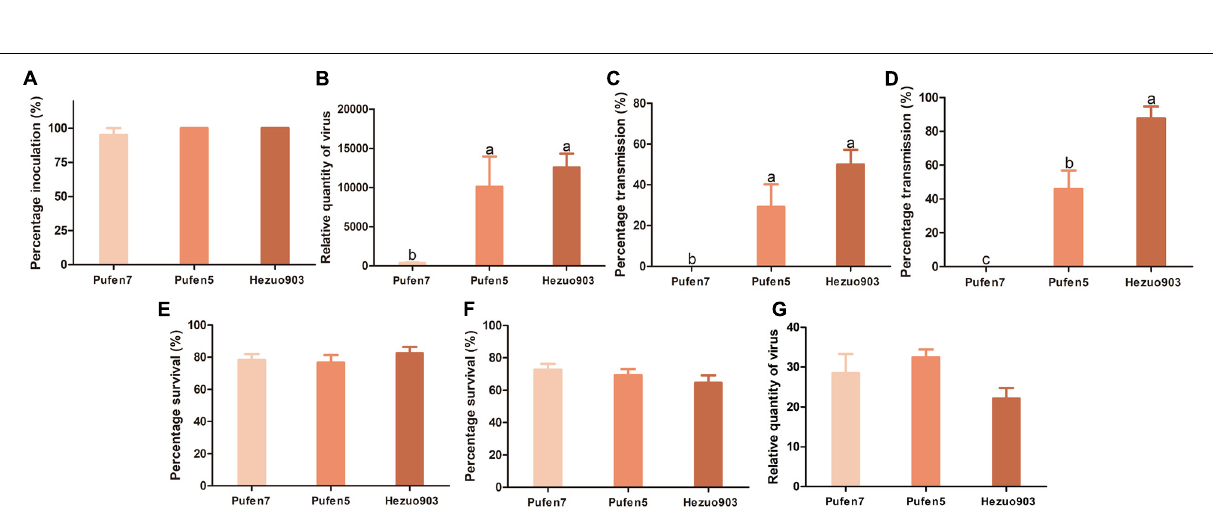
Frontiers in Plant Science |